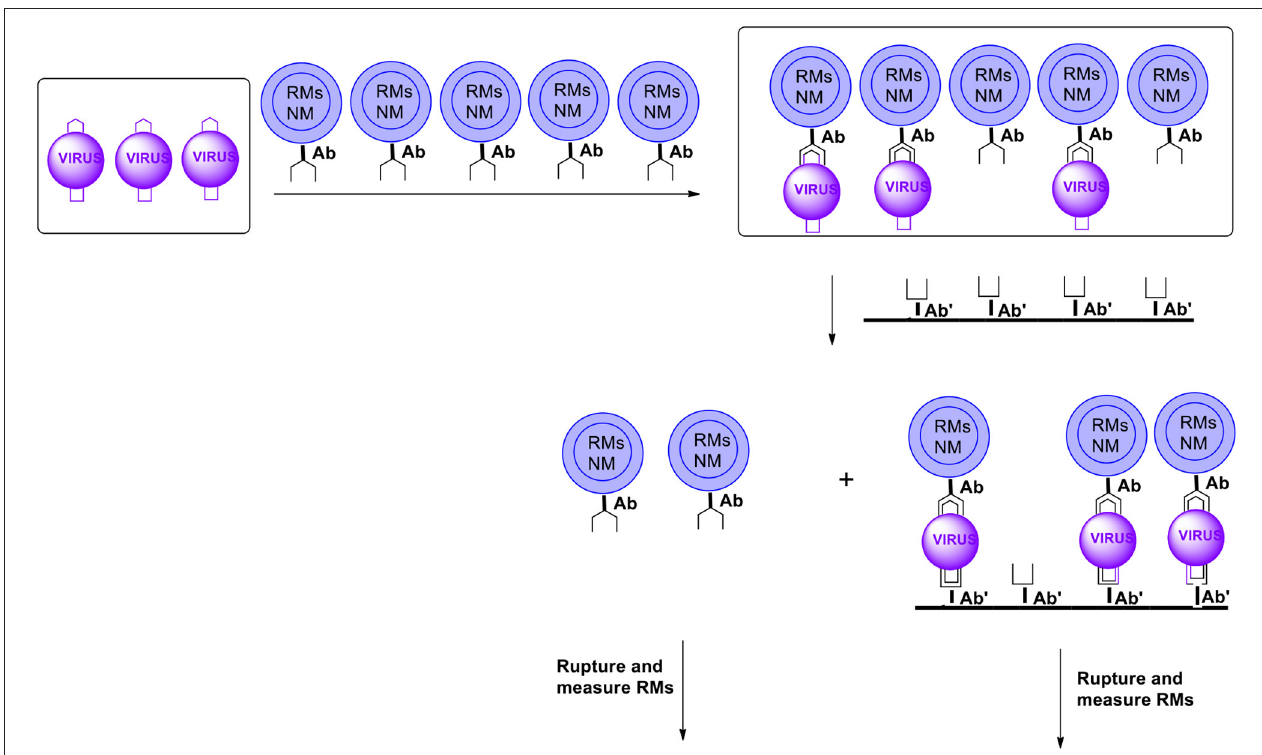
FIGURE 15 | Schematic presentation of possible ultra-sensitive detection and/or quantitation using microcapsules (RMs, reporter molecules; NM, nanomagnet; Ab, antibody). For simplicity microcapsules contain antibodies for only one pathogen (virus). Microcapsules are additionally equipped with moieties such as those carrying hydrophilicity, preventing agglomeration and non-specific binding, etc. (not shown).